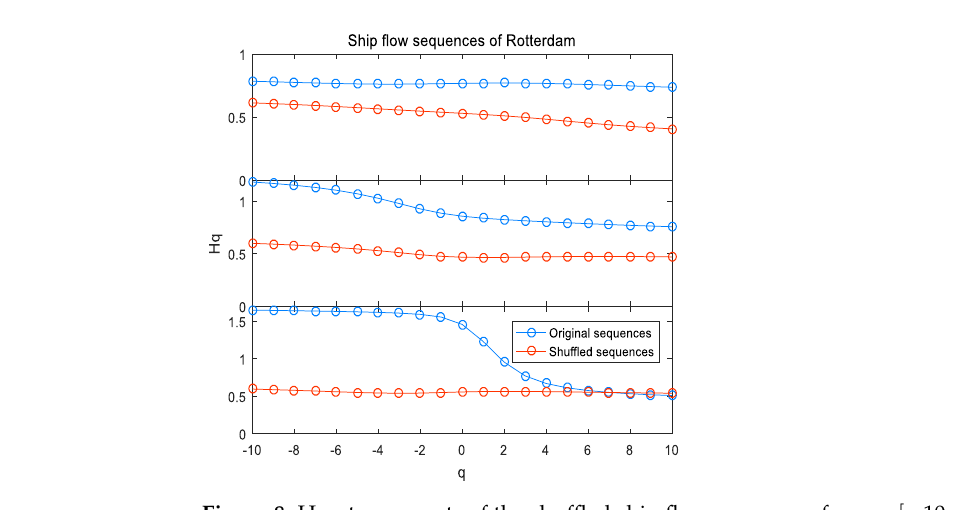
Figure 8. Hurst exponents of the shuffled ship flow sequences for q = [ − 10 : 10 ]